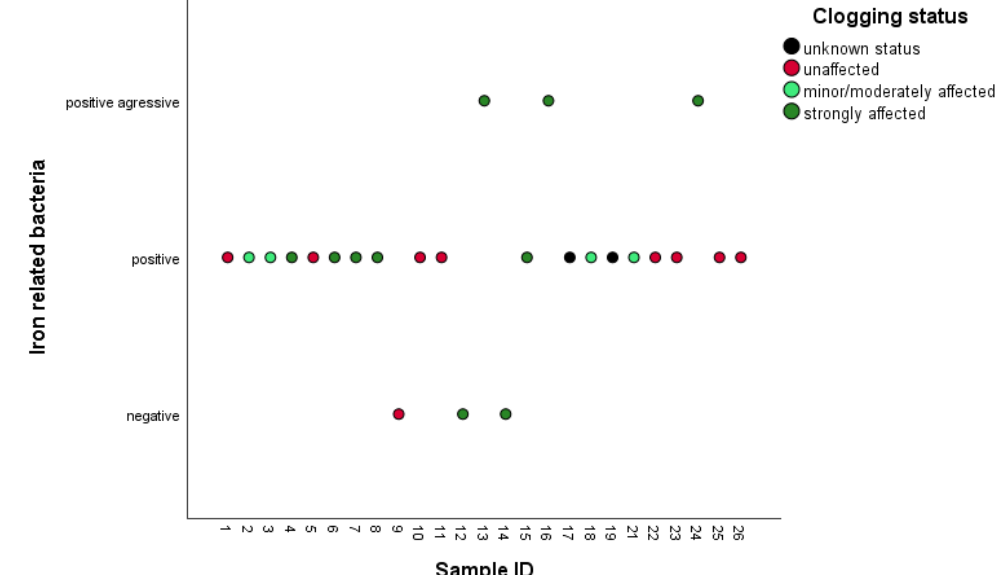
Figure 7. Iron-related bacteria (IRB) presence determined using the IRB Bart test and clogging status of bores.